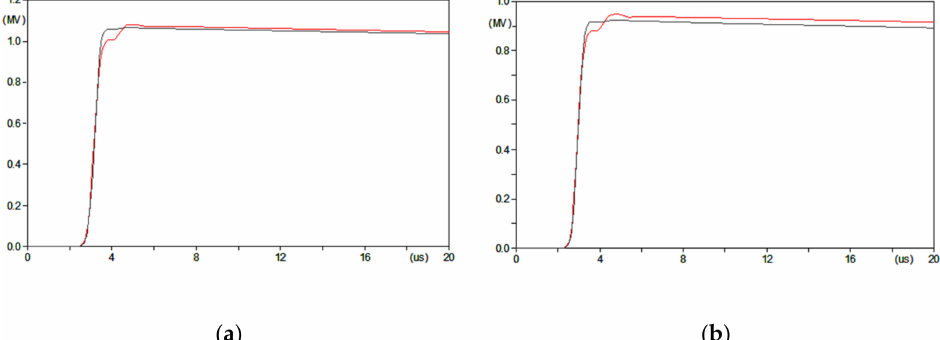
Figure 8. GPR plots against time for MT6 grounding arrangement directly injected by a lightning current. Red line: full circuit model; black line: pi-circuit model. ( a ) ρ g = 2000 Ω m, I P = 44